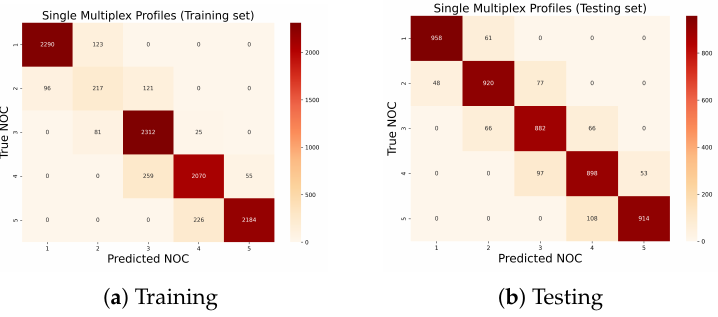
Figure 22. TAWSEEM: training and testing confusion matrices (single multiplex profiles).